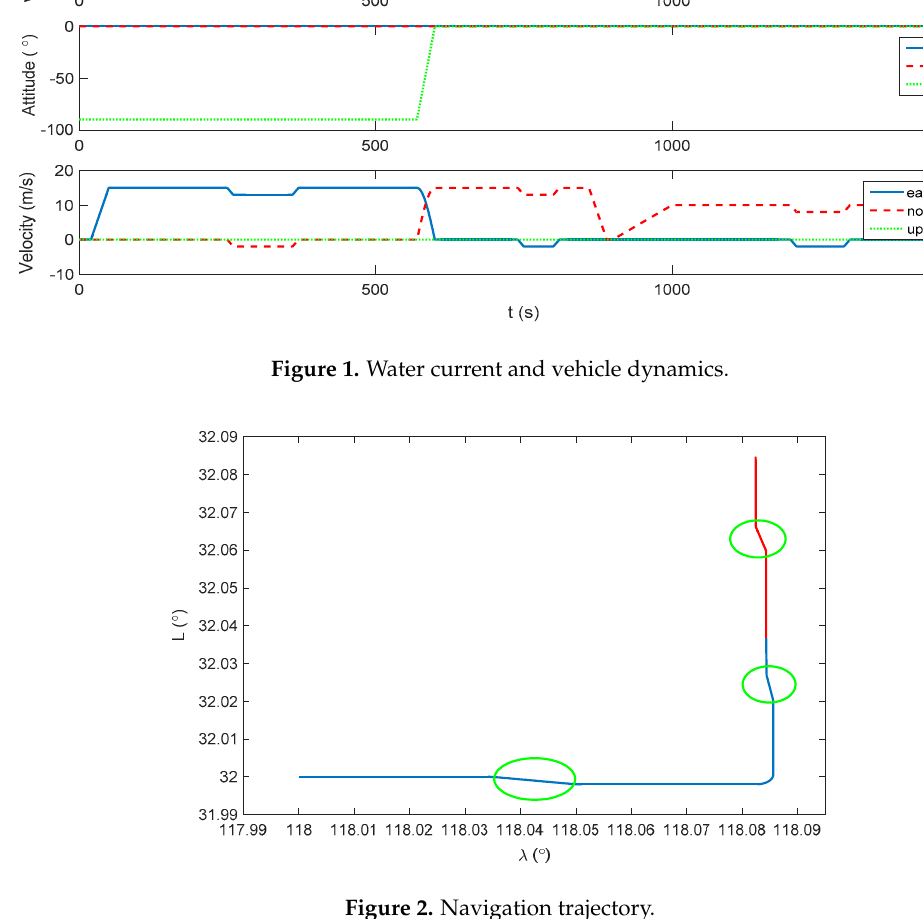
Figure 3. Attitude error of the inertial navigation system/Doppler velocity log (INS/DVL)-integrated navigation system.